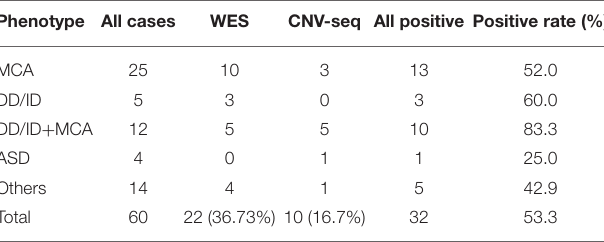
TABLE 1 | Diagnosis rates of patients with different ordering phenotype categories. Phenotype All